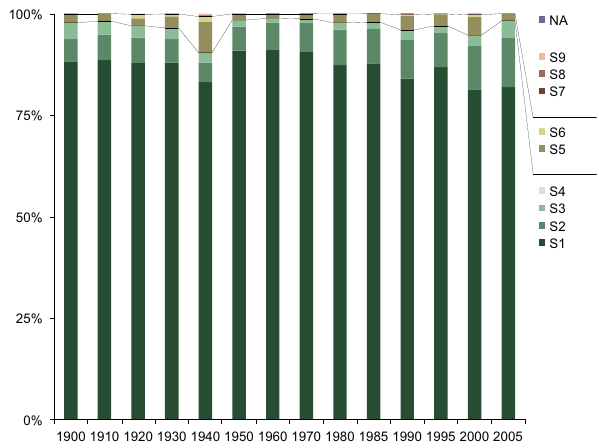
Figure B1. Relative percentage of AEI assigned to specific grid cells by the corresponding hindcasting allocation steps for product AEI_HYDE_FINAL_IR (see Table 1 for specifications). See Fig. 2 for the explanation of steps S1–S9. NA refers to AEI reported in the sub-national statistics but not assigned to grid cells (e.g. because the unit was too small to show up in the gridded product).